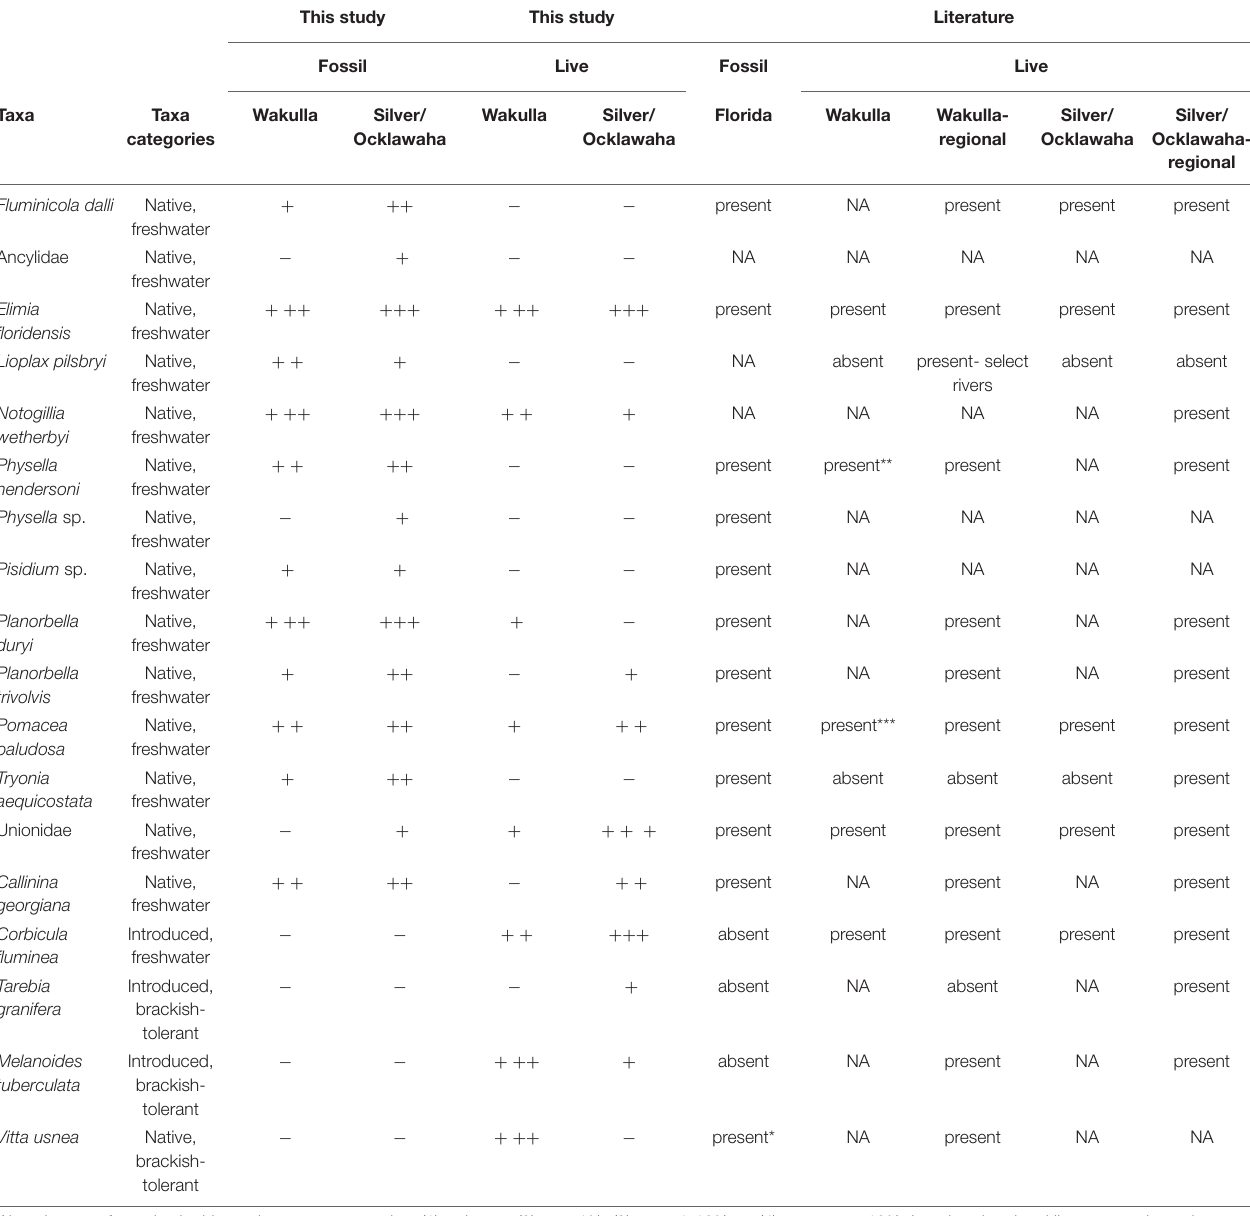
TABLE 2 | Abundances of aquatic species present in fossil and live samples compared to local and regional